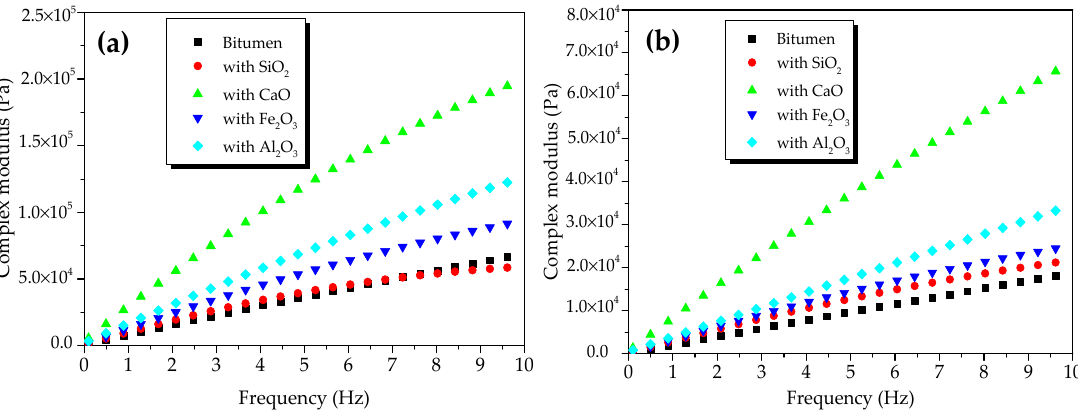
Figure 4. Complex shear modulus of oxide component-modified bitumen mixtures at different temperatures: ( a ) 45 °C and ( b ) 55 °C.